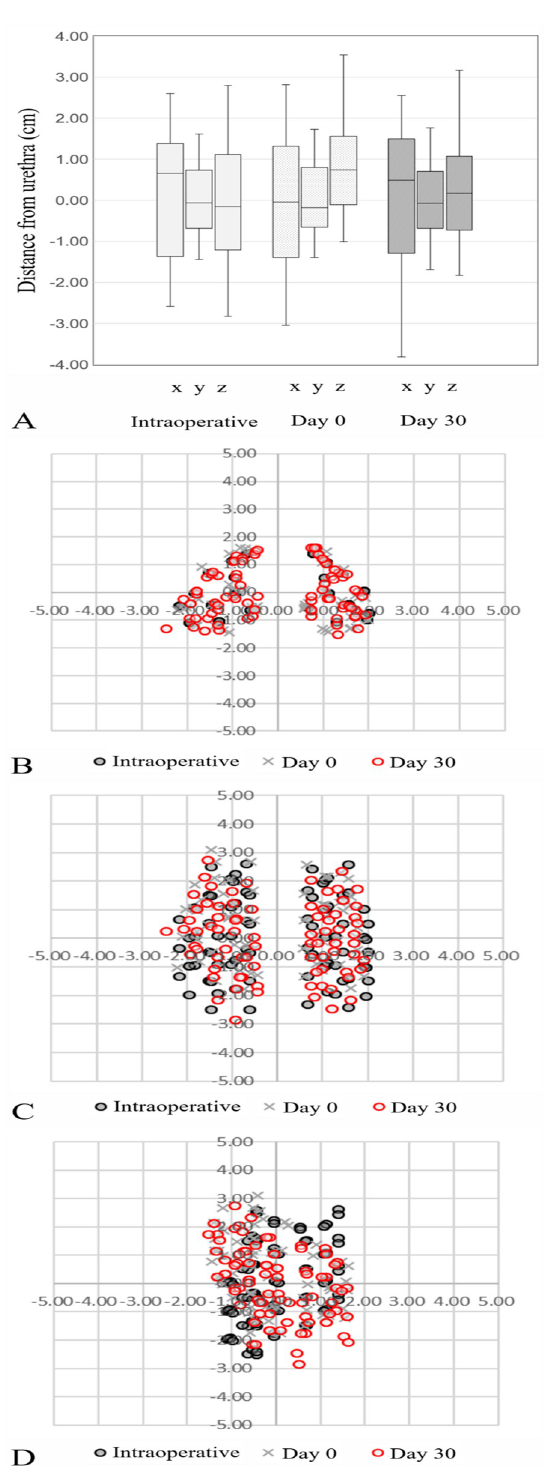
Fig 6. (A) Box plots summarizing seeds placement pattern in terms of distance from the urethra in x-, y-, and z-axis. (B), (C), (D) Exemplary intraoperative seed displacement patterns (1 case) on transrectal ultrasound images and post- implant patterns (day 0 and day 30) on computed tomography. The displacement pattern of seeds in the (B) transverse view, (C) coronal view, and (D) sagittal view.